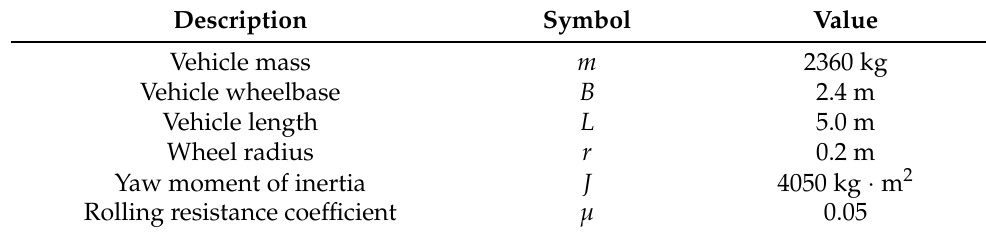
Table 1. Specifications of the dynamic model.